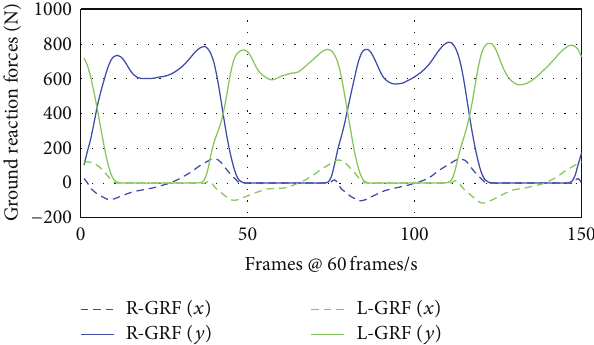
Figure 8: Ground reaction forces for two strides walking, right limb (blue), and left limb